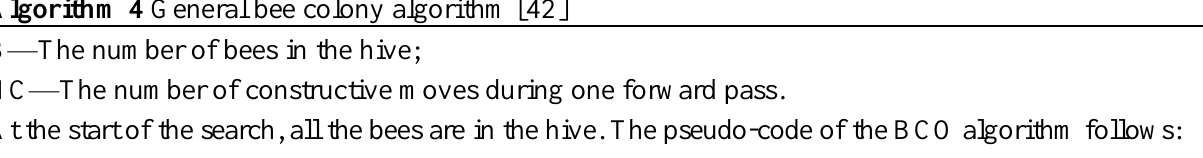
Algorithm 4 General bee colony algorithm